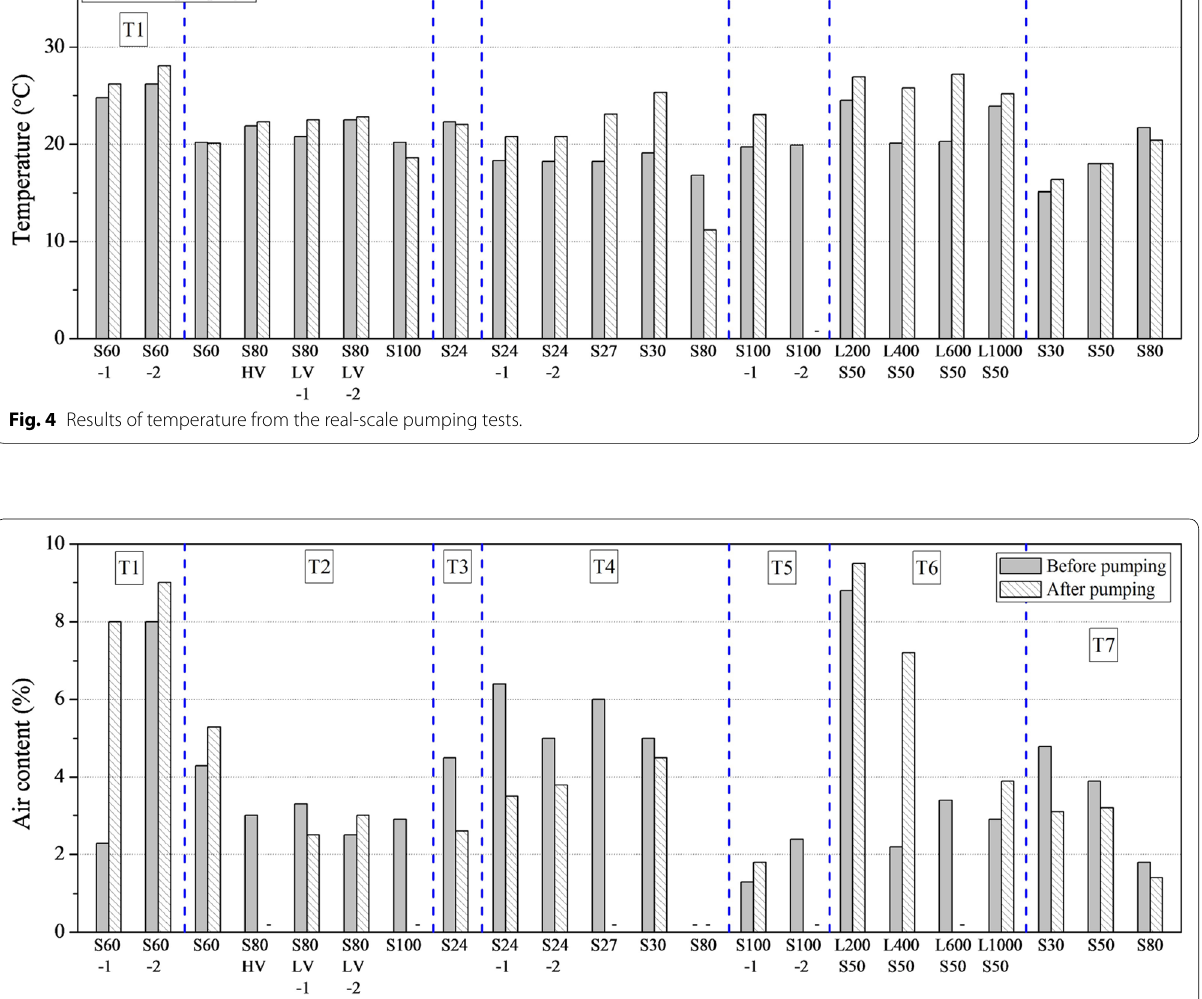
Fig. 5 Results of air content from the real-scale pumping